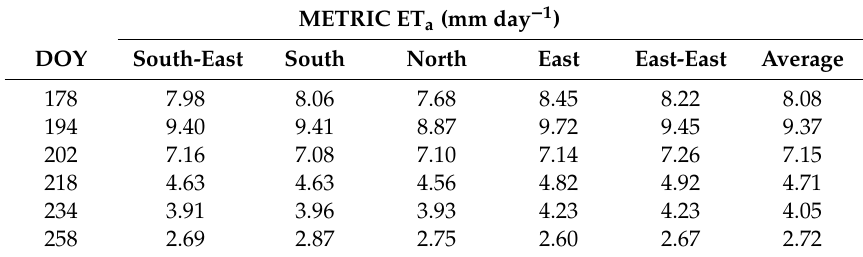
Table 5. ETa values estimated by the METRIC model for five observation locations and six overpass dates during